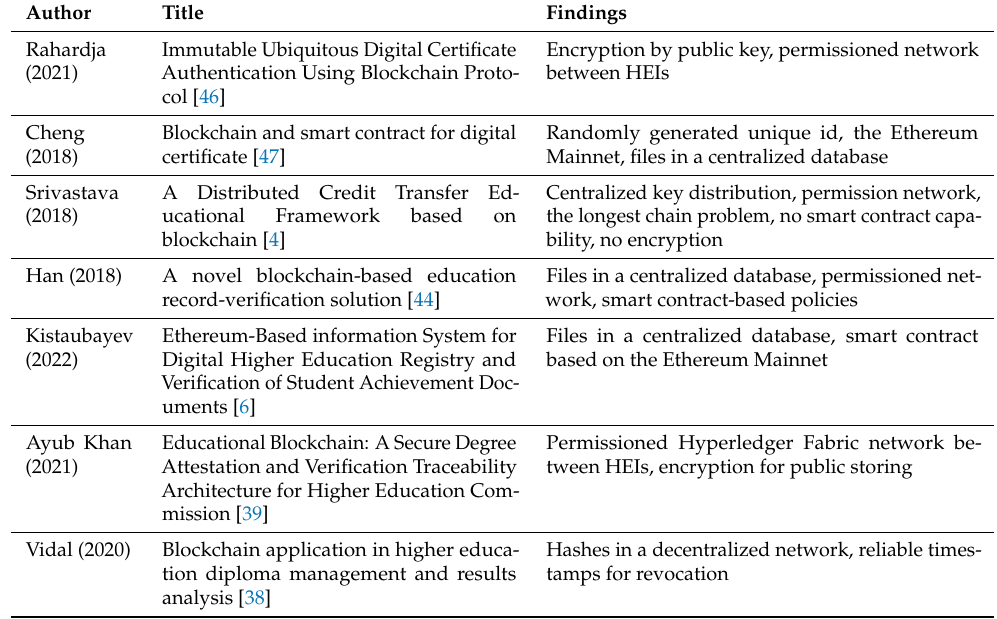
Table 2. Certificates issuing and verification summary